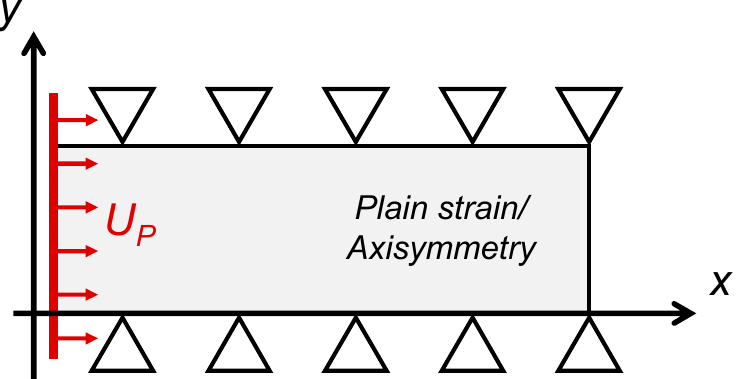
Figure 5. Scheme of the numerical models used for the investigation of the propagation of planar and cylindrical waves in solids: formulations, boundary conditions, and constraints.